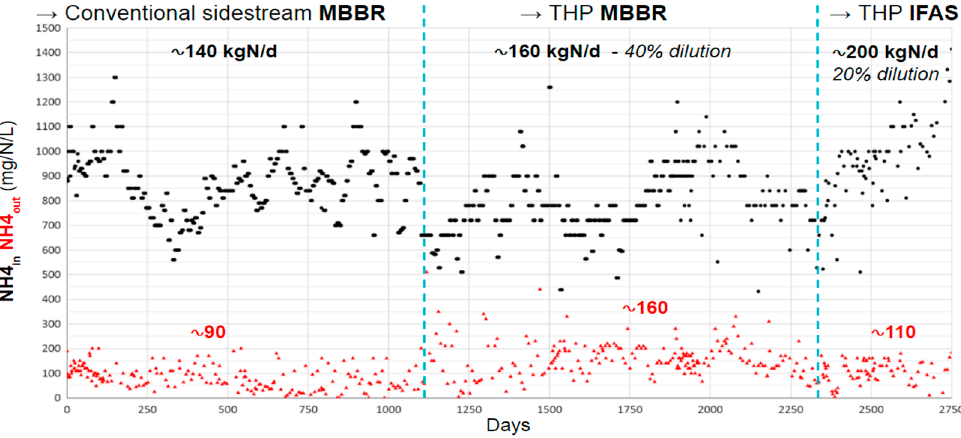
Figure 9. NH 4 concentration in the inlet and outlet of the ANITA Mox in